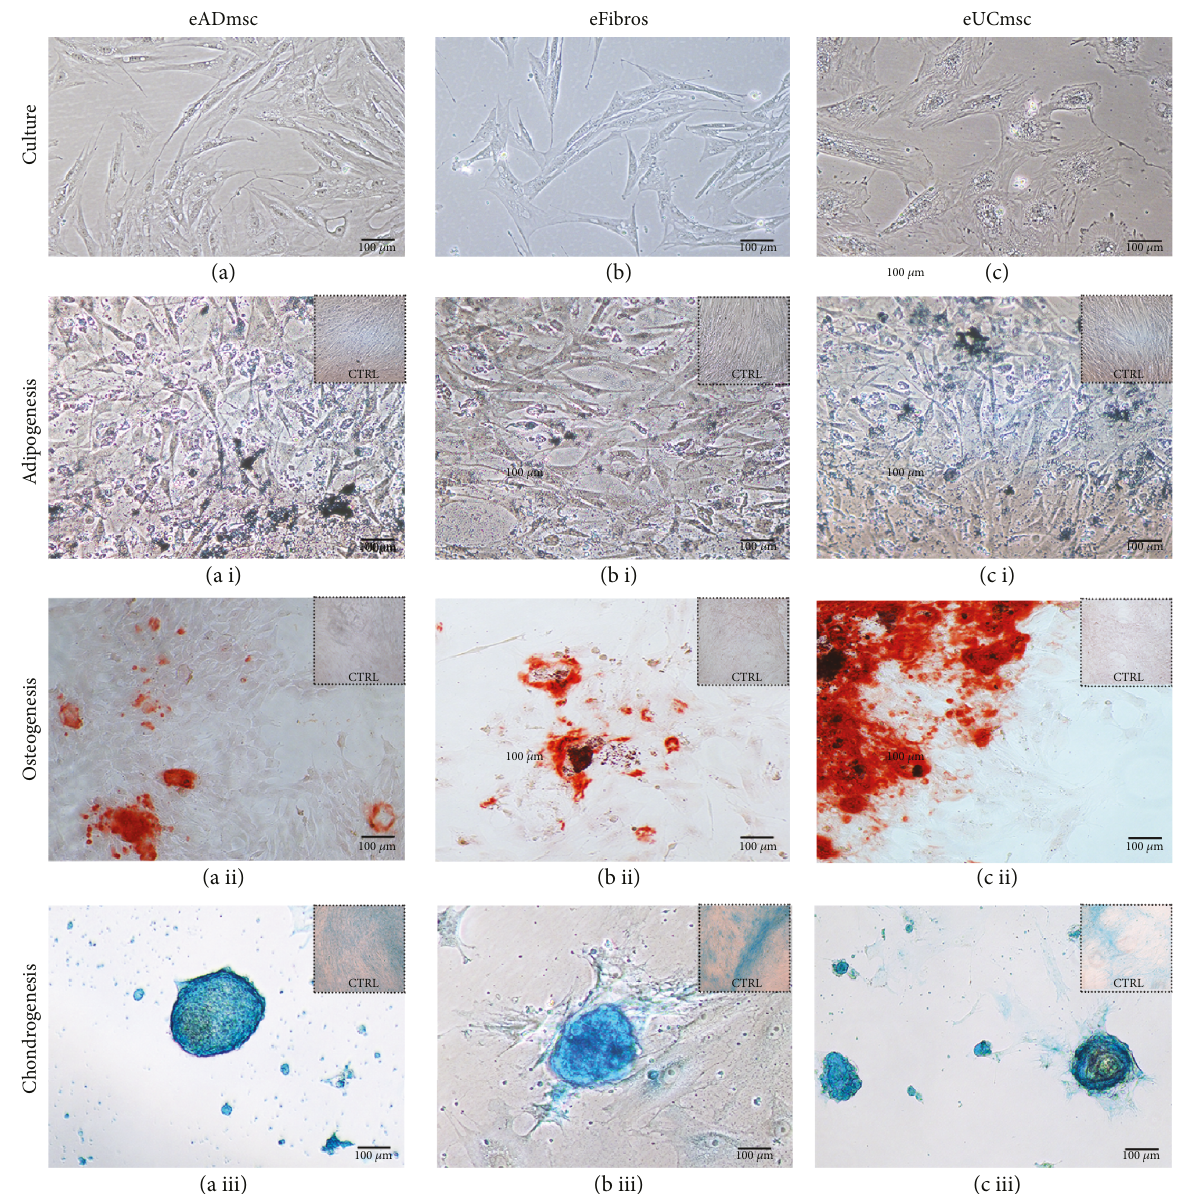
Figure 1: (a) Adipose tissue mesenchymal cells, (b) fi broblasts, and (c) umbilical cord tissue mesenchymal cells, 200x. After multilineage di ff erentiation, it is possible to observe (a i, b i, and c i) adipogenic di ff erentiated cells characterized by Sudan black-stained lipid vacuole accumulation, 200x; (a ii, b ii, and c ii) osteogenic di ff erentiated cells characterized by calcium deposition, which were stained with alizarin red, 100x; and (a iii, b iii, and c iii) chondrogenic di ff erentiated cells characterized by chondrogenic pellet development, which were stained with Alcian blue, 200x. Negative control cells maintained the typical spindle-like shape and di ff ered from the treated